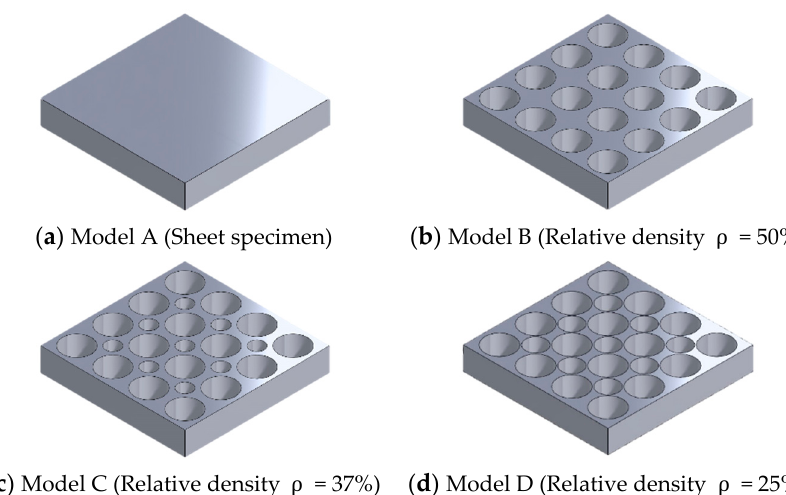
Figure 3. TPE specimens for finite element analysis (FEA).